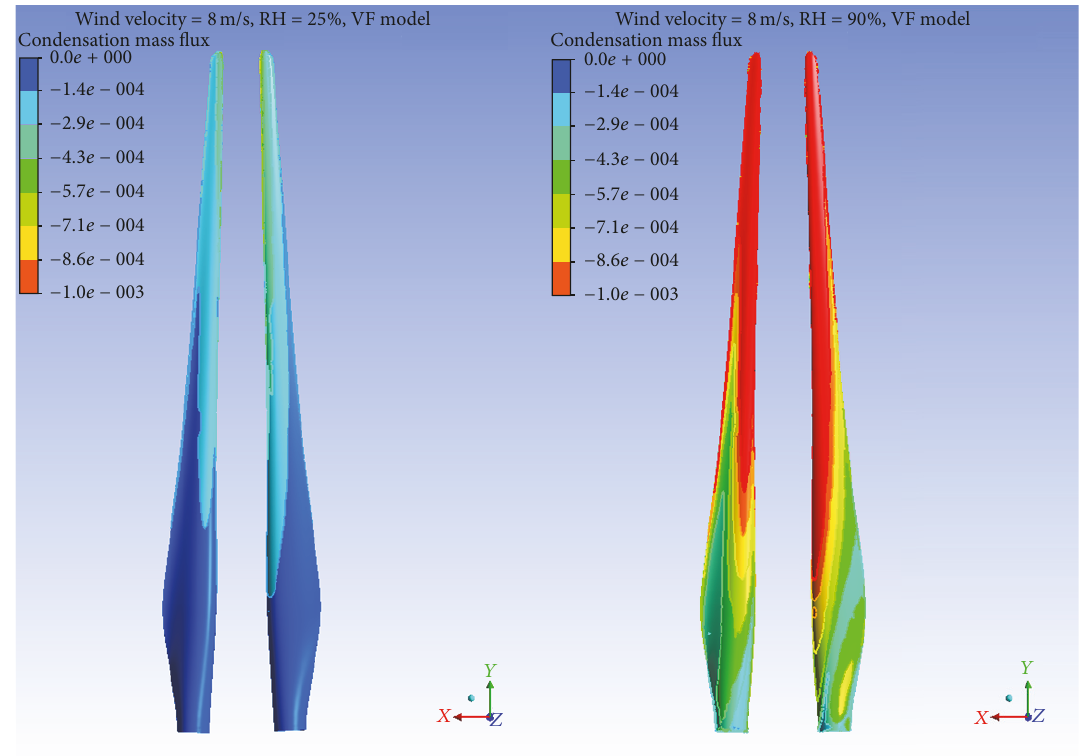
Figure 16: Condensation mass flux on blade surface for 𝑉 = 8m/s.